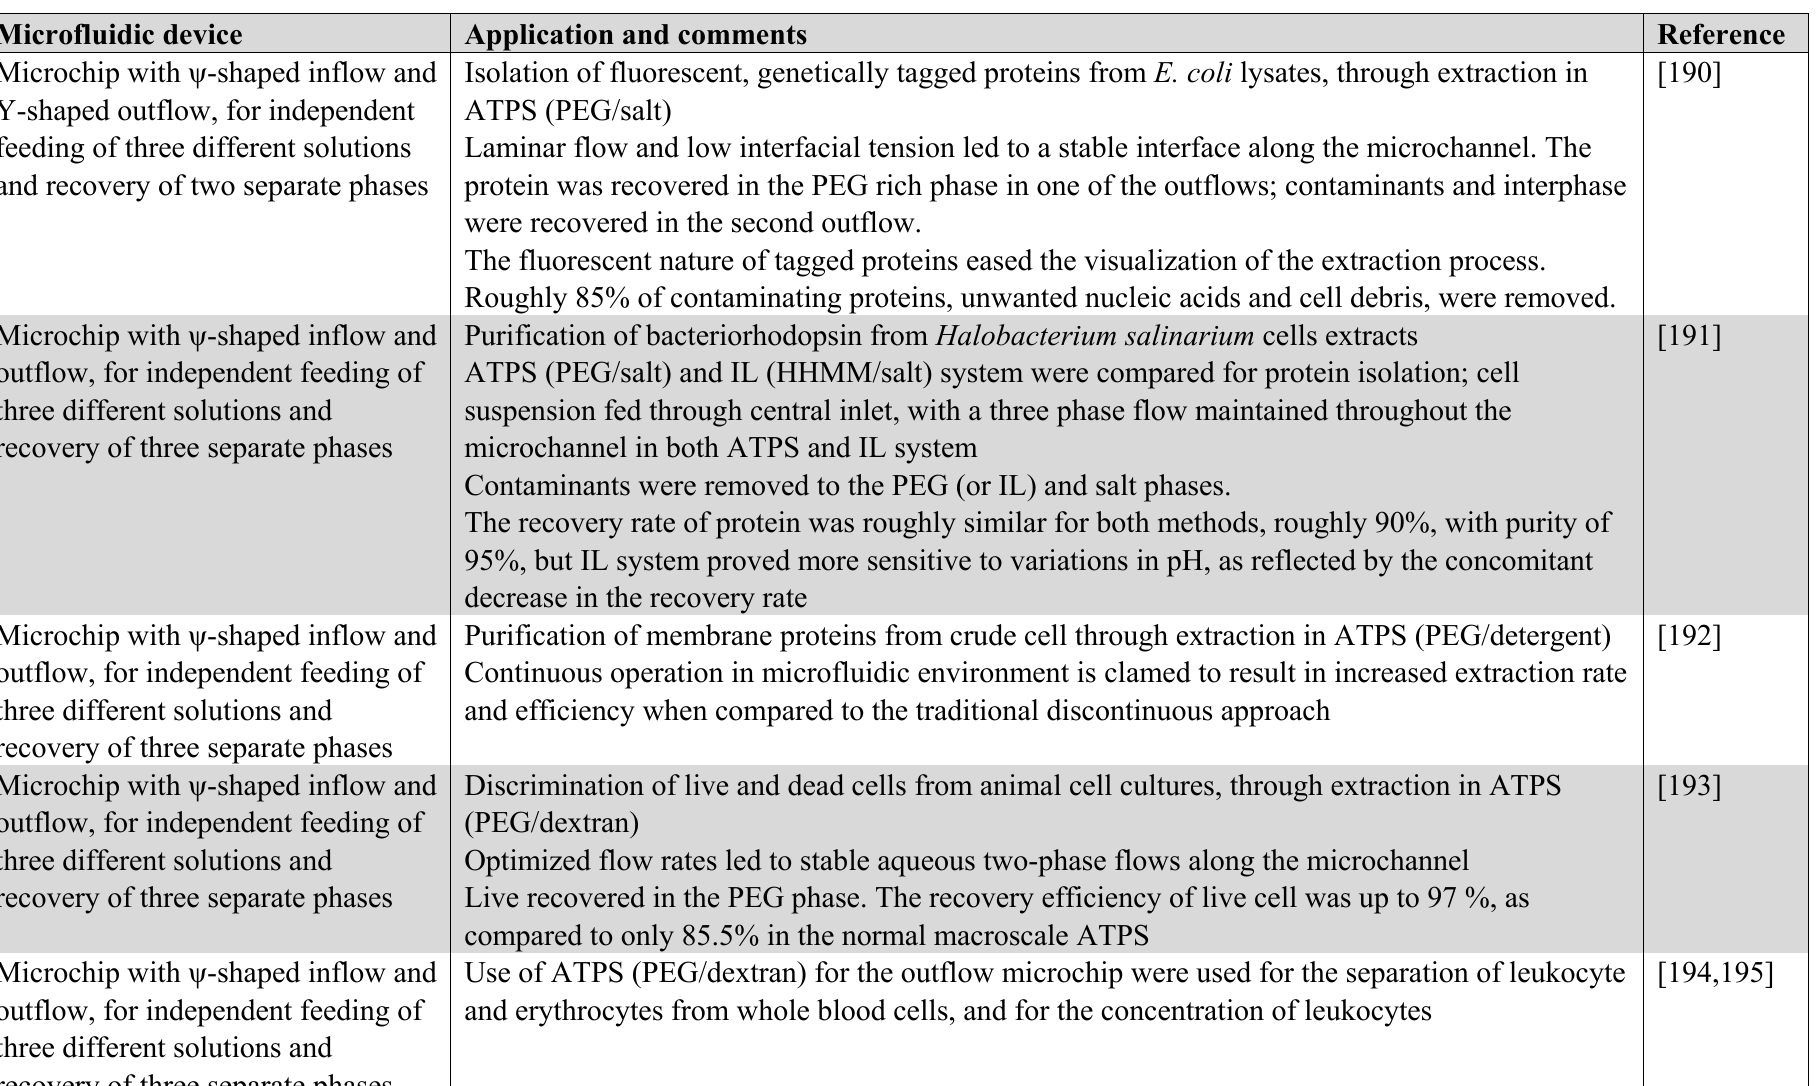
Table 5. Application of microfluidic devices in downstream processing: some